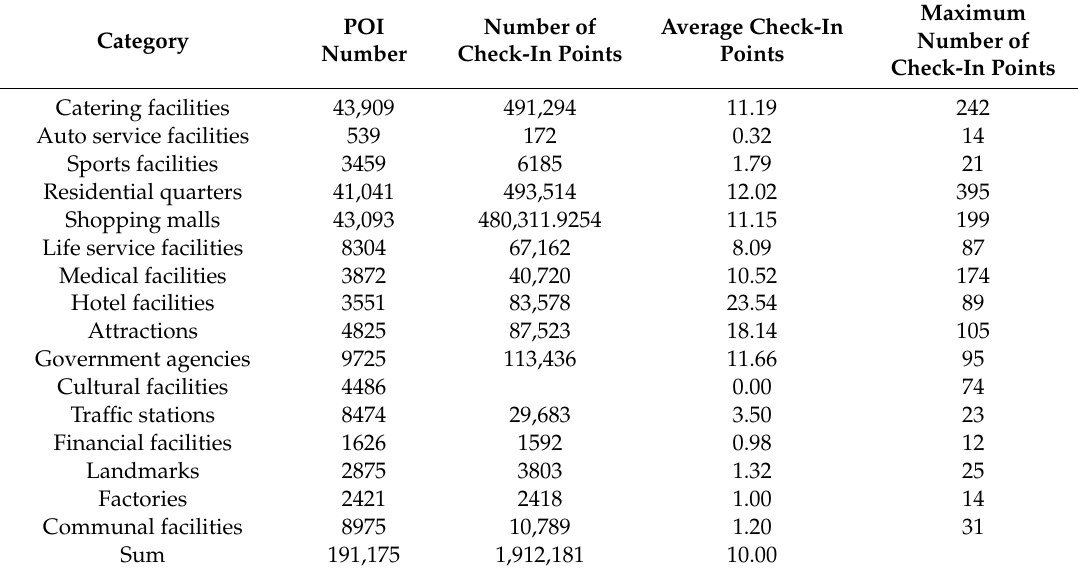
Table 2. Similarity matching results of each POI category.